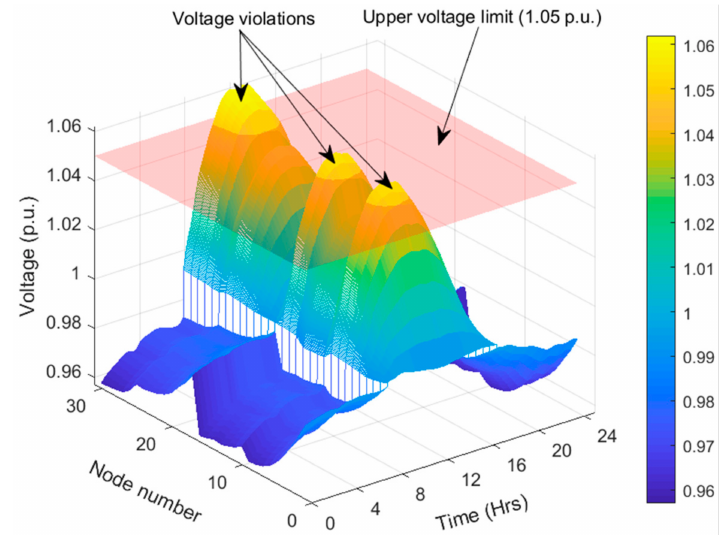
Figure 7. Daily variation of nodal voltages without voltage control. Figures 8–10 depict the daily variation of the nodal voltages, active power generation, and reactive power absorption with the above controllers, respectively.